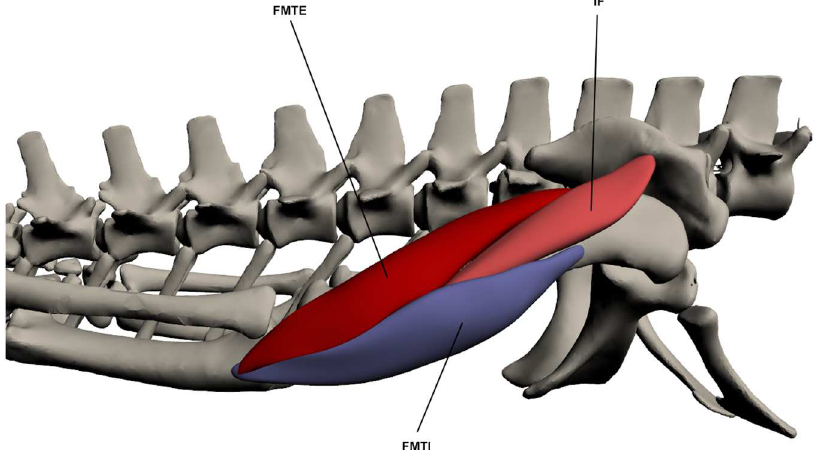
Fig 15. Deep dorsal muscles of the upper hindlimb. FMTE: Femorotibialis externus , IF: Iliofemoralis , FMTI: Femorotibialis internus .